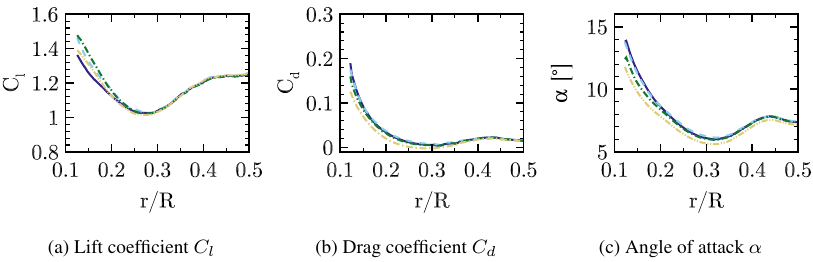
Figure 33. Distribution of aerodynamic coefficients along the blade radius for CaseT1.0 (solid), CaseT1.0-rounded (dashed), CaseT1.0-fairing (dashed dot) and CaseT1.0-dYm05 (dashed dot